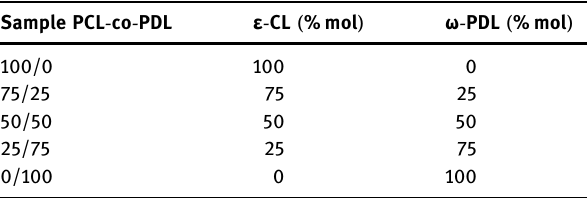
Table 1: Monomer ratio composition for the polymers